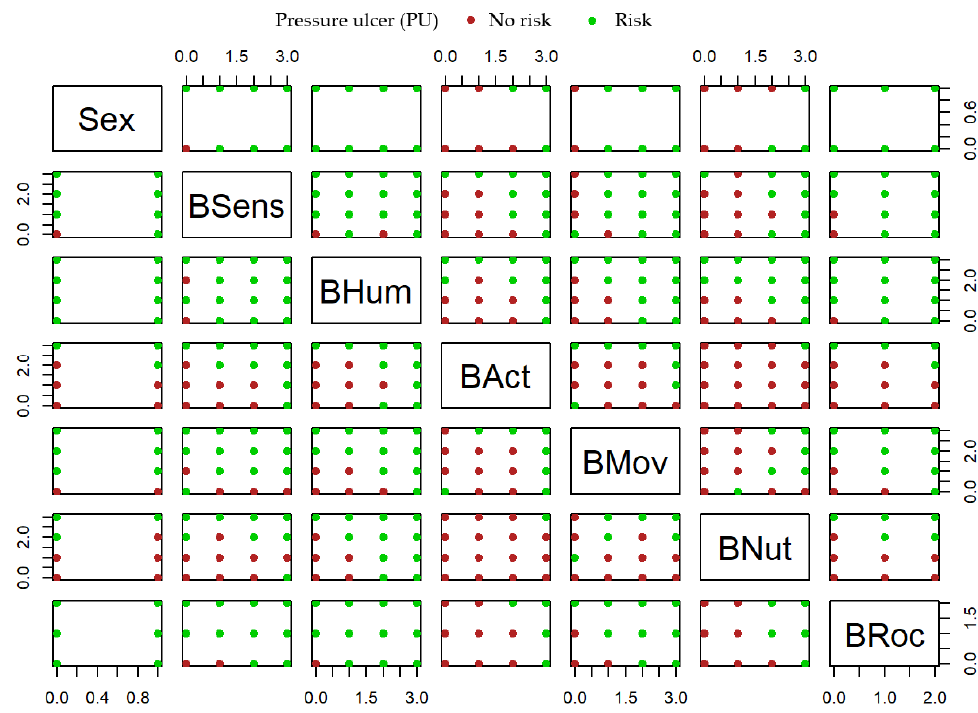
Figure 2. PU risk classification based on two subscales.